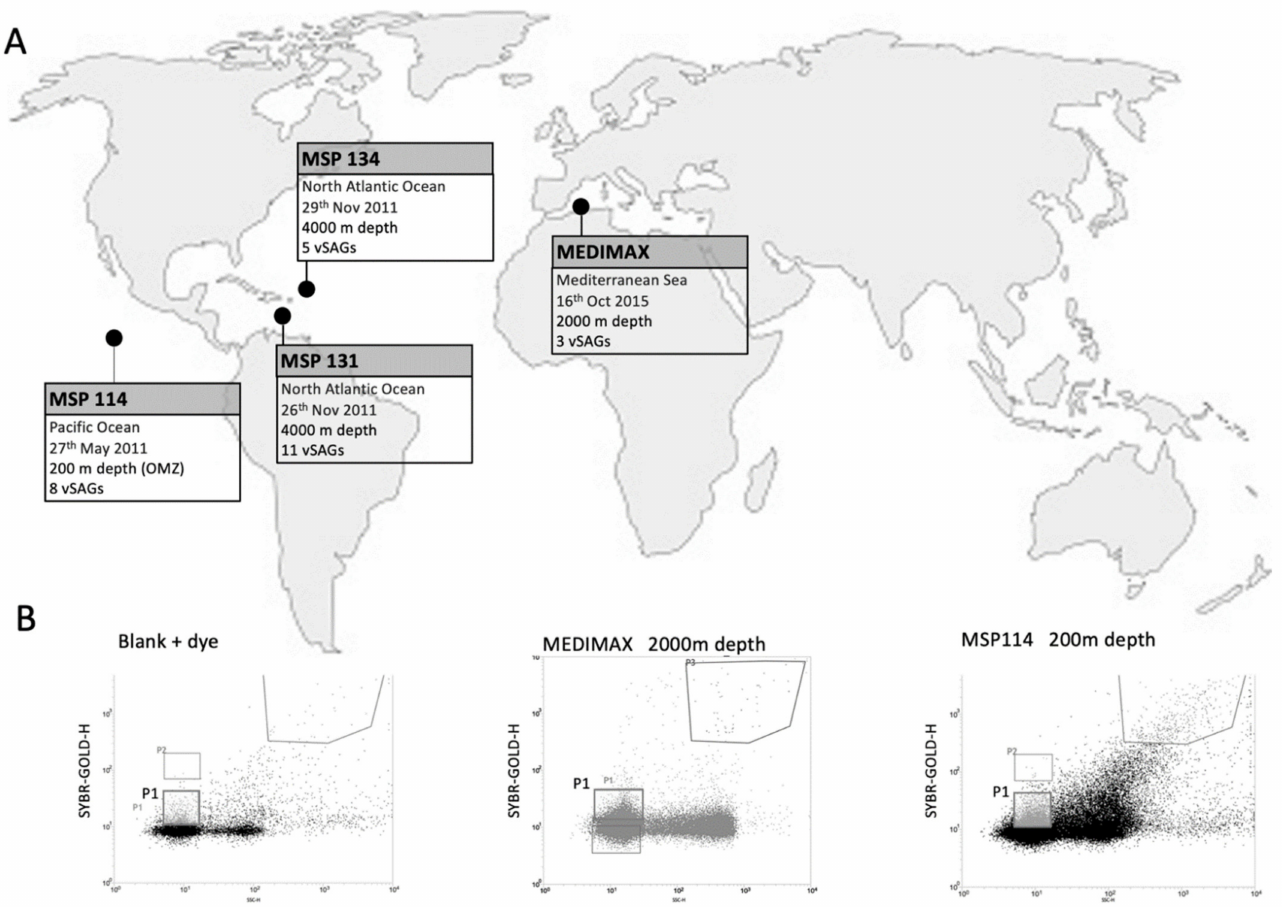
Figure 1. ( A ) Sampling information map. Location, date, depth and number of viral single amplified genomes (vSAGs) are indicated for each sampling point. ( B ) Flow cytometry sorting plots and gates for blanks (left panel; SYBR Gold-stained buffer TE), 2000 m depth MEDIMAX (middle panel), and MSP114 200 m depth (right panel; OMZ) samples. P1 gate, which shows the viral population, was employed to sort the single viruses employed in this